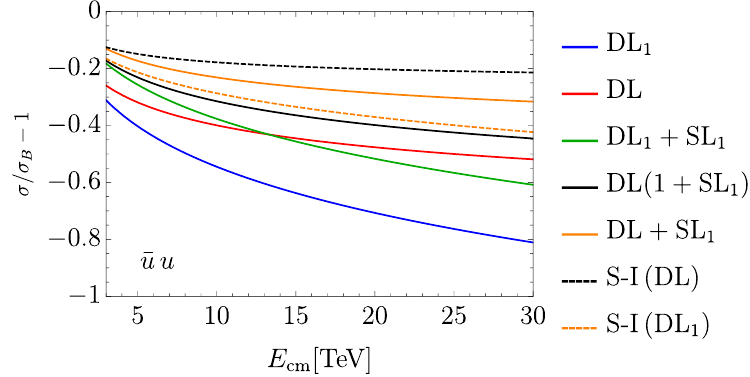
Figure 3. Impact of radiative corrections on the production of two up quarks at the VHEL. The solid lines represent different predictions for the exclusive cross-section. The dashed lines are double-logarithm semi-inclusive cross-sections resummed (in black) or at one loop (in